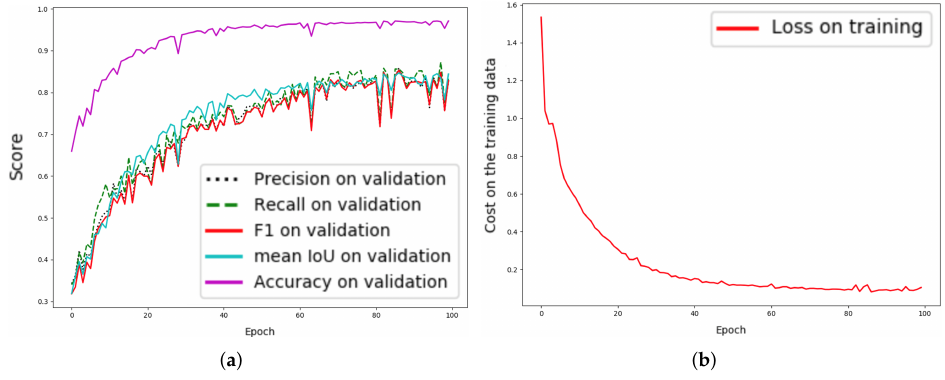
Figure 5. The learning curves for the proposed approach, “E-PRM-VS-TF”, on the Thailand Landsat-8 corpus; x refers to epochs and y refers to different measurements: ( a ) plot of model loss (cross-entropy) on training and validation corpora and ( b ) performance plot on the validation